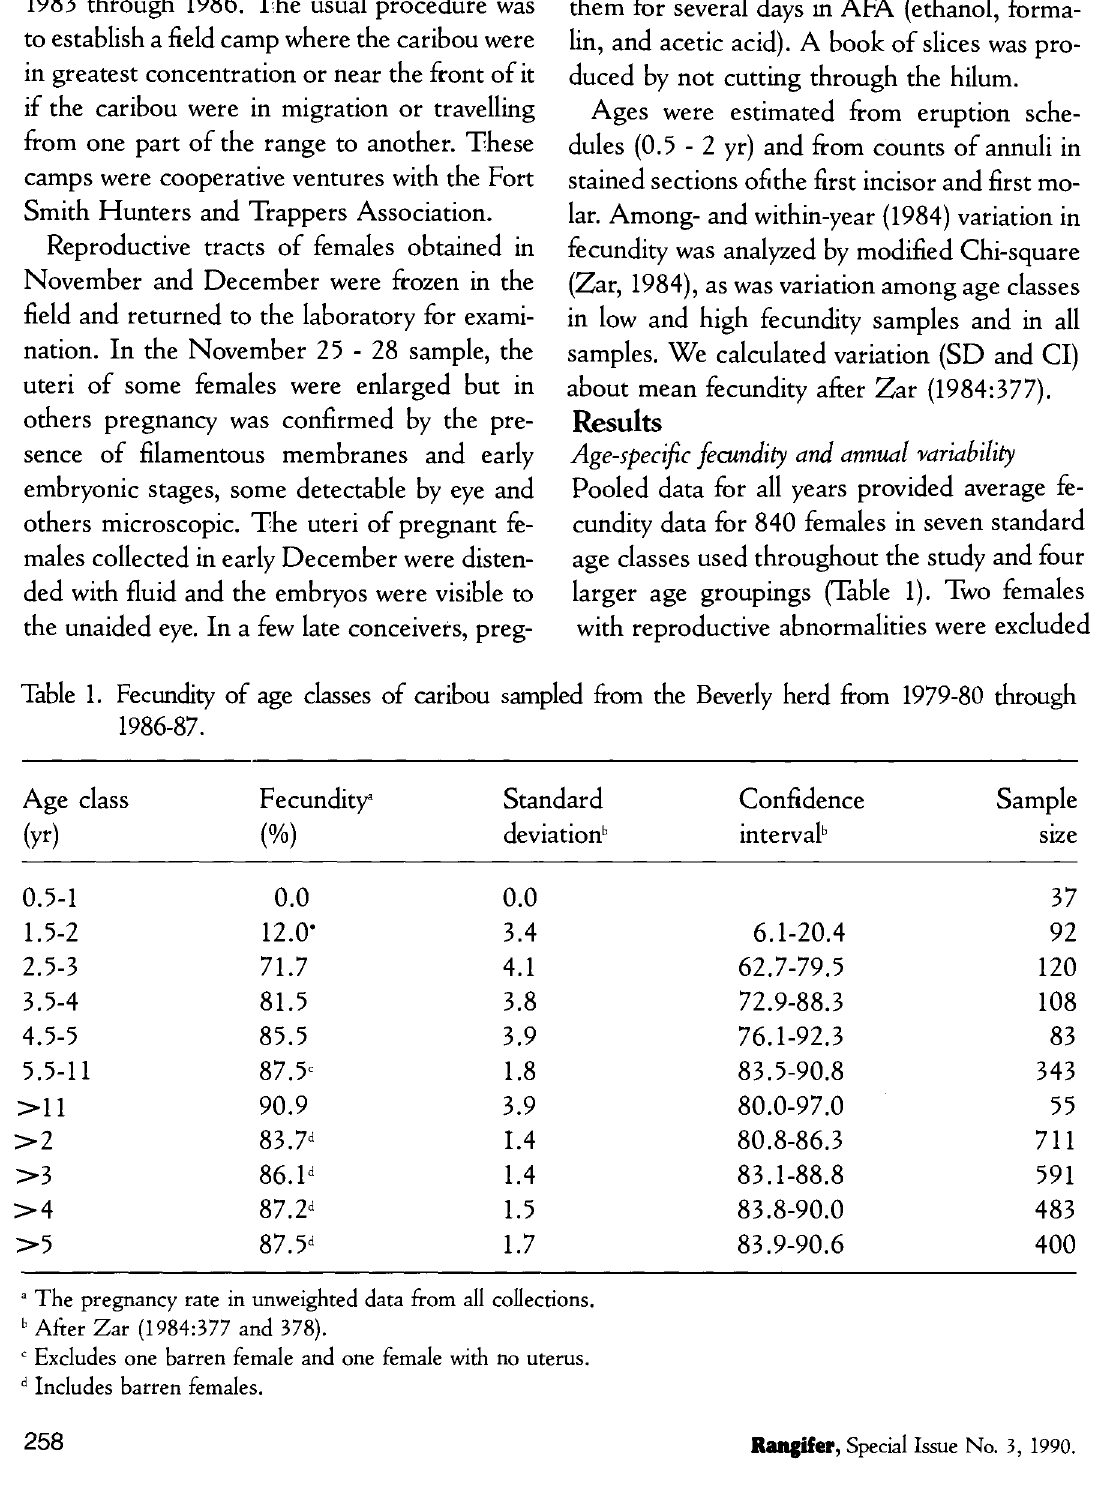
Table 1. Fecundity of age classes of caribou sampled from the Beverly herd from 1979-80 through